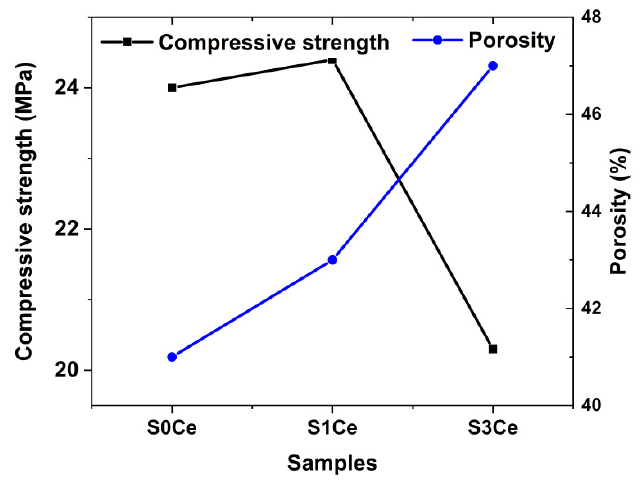
Figure 6. Porosity (blue line) and compressive strength (black line) of S0Ce-S1Ce composite scaffolds.